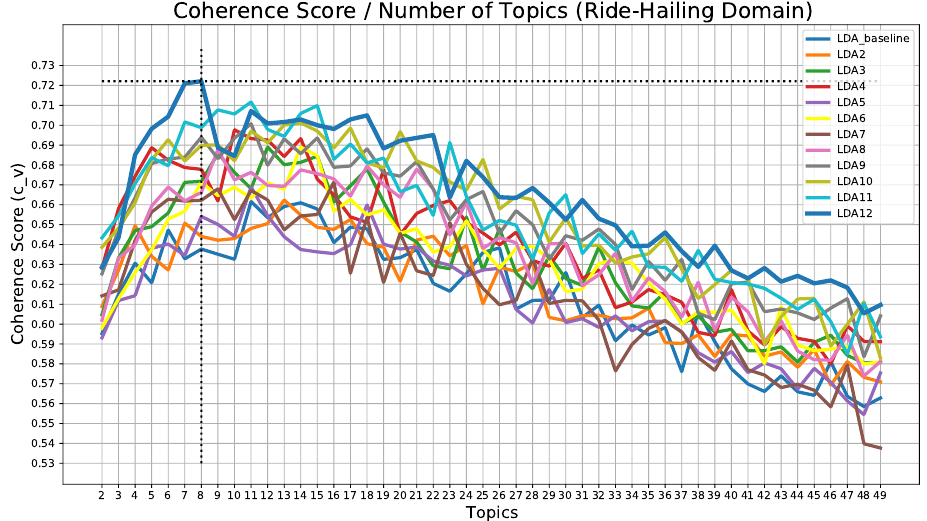
Figure 5. Analyzing the Coherence Score results for each preprocessing pipeline between 2 and 50 topics.